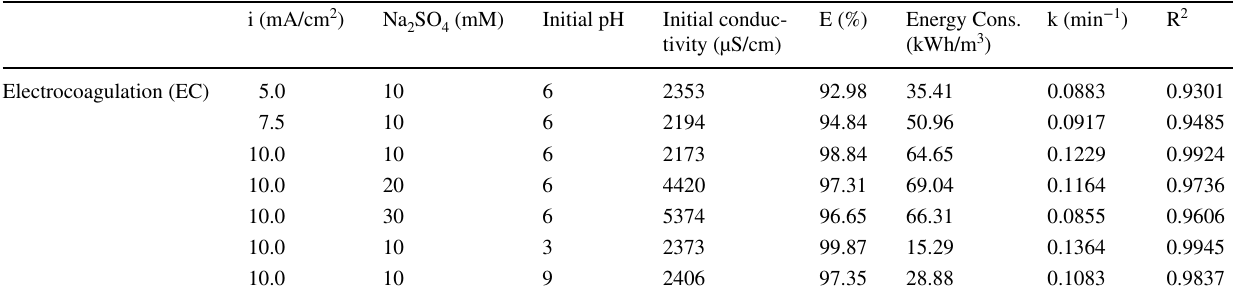
Table 3 The treatment results of EC method